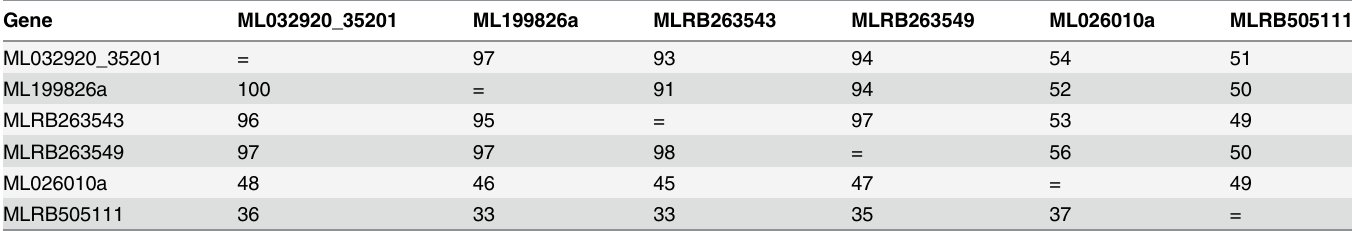
Table 2. Percent Identity Matrix of Mnemiopsis genes and proteins.